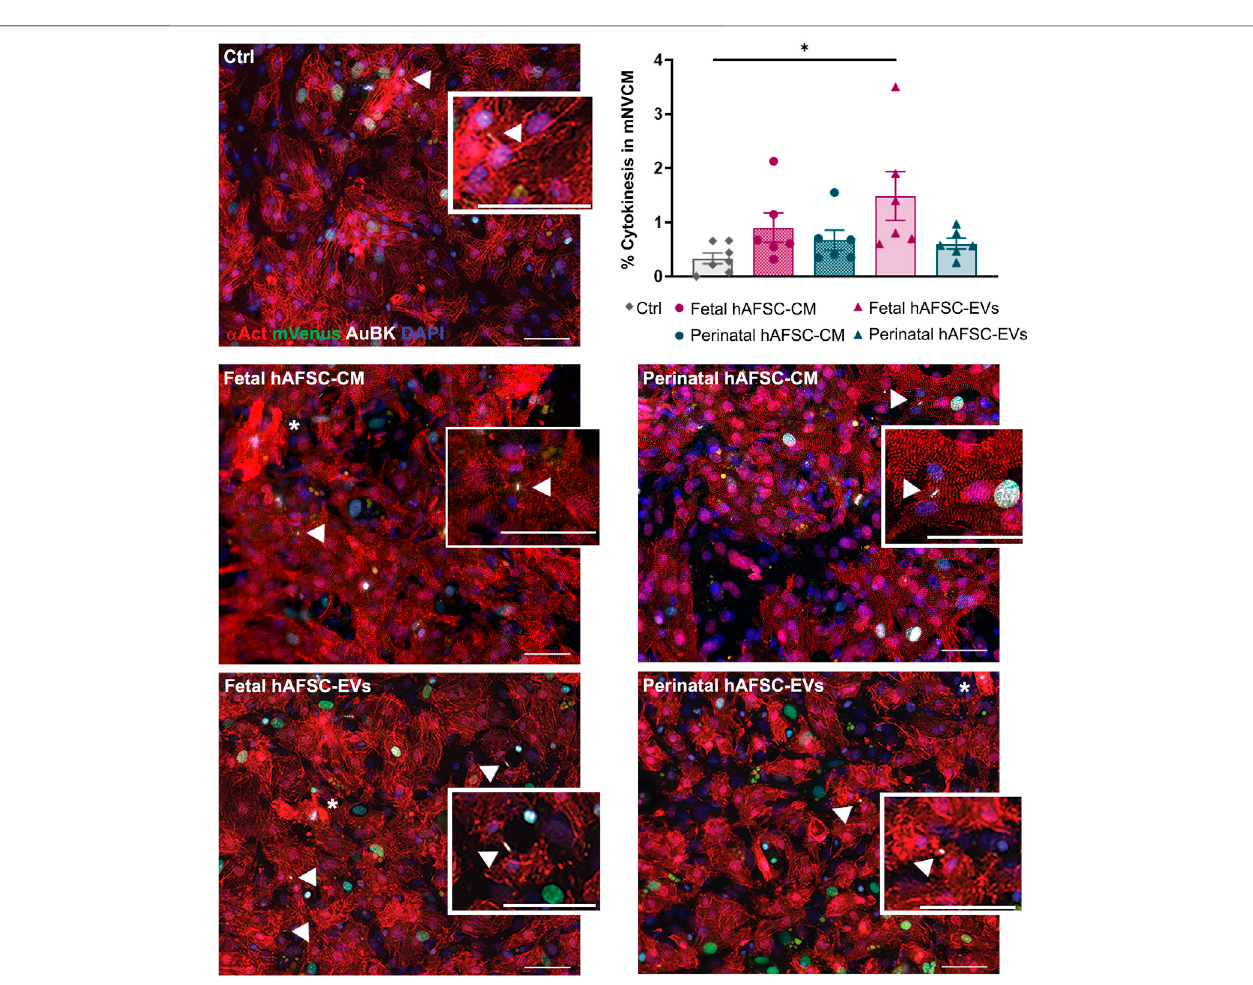
FIGURE 2 | In vitro cytokinesis of mNVCM following stimulation by fetal versus perinatal hAFSC secretome formulations. Representative images of AuBK localizationatcellmid-bodyinR26pFUCCI2 +/ − mNVCMinvehicle-treatedcontrolconditions(SFmedium,Ctrl)orfollowingtreatmentwithfetalorperinatalhAFSC-CMor hAFSC-EVs by immunostaining for sarcomeric α -actinin ( α Act, red), mVenus-Geminin (mVenus, green), Aurora B kinase (AuBK, white), and DAPI (blue), scale bar: 50 µm.WhitearrowsindicateAuBKexpressionatcellmid-body,correspondingtothecompletionofcytokinesisin α Act-positivecells(mNVCM),asillustratedinthe inlet magni fi cation, scale bar: 50 µm; white asterisks indicate mNVCM with disarranged α -actinin expression as sarcomeric disassembly feature. Upper right panel: evaluationof α Act-positivecells(mNVCM)withAuBKexpressionatcleavagefurrowsfollowingstimulationwithfetalversusperinatalhAFSCsecretomeformulationsover vehicle-treated control condition (Ctrl). All values are expressed as mean ± s.e.m. percentage of dividing cardiomyocytes (% Cytokinesis in mNVCM) in independent experiments(Ctrl:0.33±0.09%, n =7;fetalhAFSC-CM:0.90±0.27%, n =6;perinatalhAFSC-CM:0.67±0.18%, n =6;fetalhAFSC-EVs:1.48±0.45%, n =6;perinatal hAFSC-EVs: 0.60 ± 0.10%, n = 6; * p =